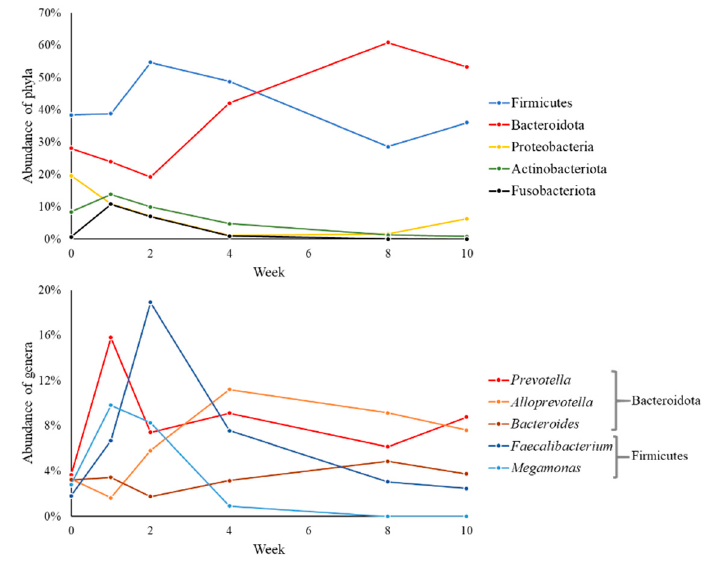
Figure 6. Relative abundance of bacterial phyla and genera in fecal samples during pre- and post- weaning in dairy calves fed different levels and sources of NDF.